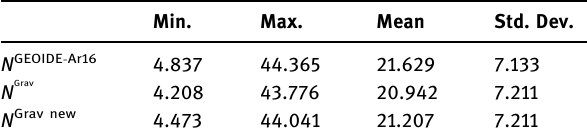
Table 5: Statistics of GEOIDE - Ar16 and the pure gravimetric geoid models, N Grav and N Gravnew , in meters Min. Max. Mean Std. Dev.